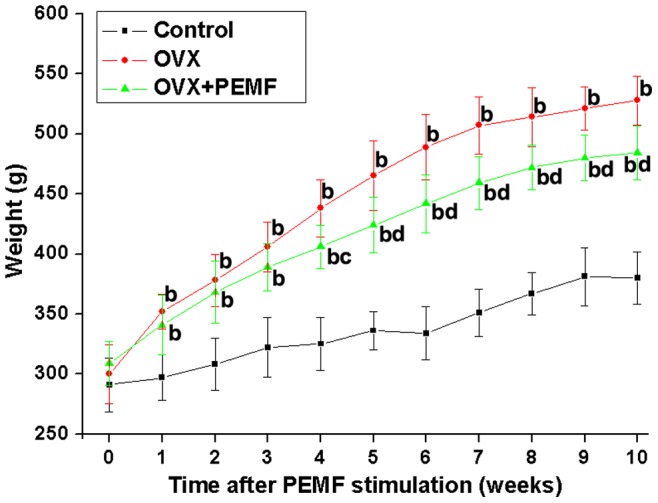
Effects of PEMF exposure on the weekly average body weights of OVX rats throughout the 10-week experimental period.Control, sham-operated control group; OVX, ovariectomy group; OVX+PEMF, ovariectomy with PEMF exposure group. Values are all expressed as mean ± S.D. (n = 10). bSignificant difference from the Control group with P<0.01; bcSignificant difference from the Control group with P<0.01 and OVX group with P<0.05; bdSignificant difference from the Control group and OVX group with P<0.01.